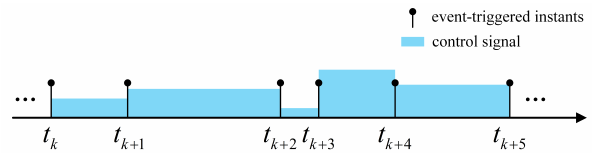
Figure 1. Schematic diagram of event-triggered